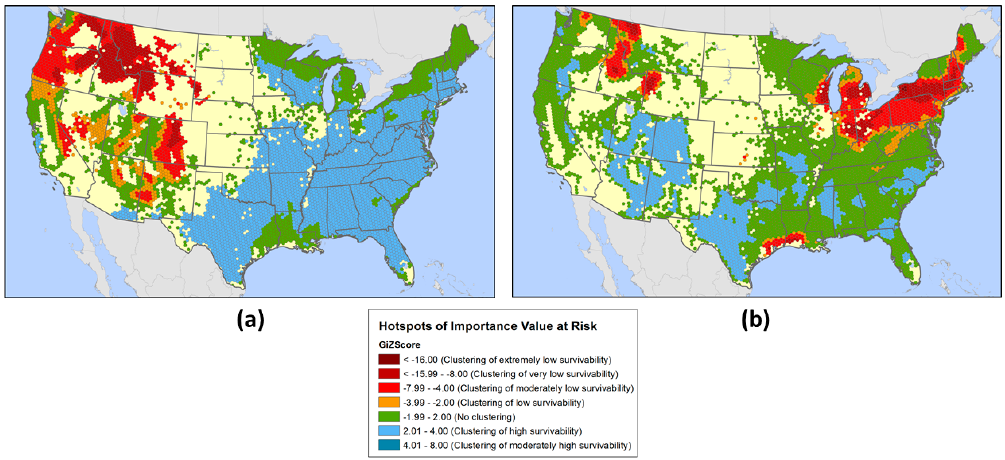
Figure 4. Hotspots and coldspots of Importance Value at Risk (IVAR) for plots within 834 km 2 hexagons, for insect agents. G i * scores ≤ − 2 (red) are significant clusters of low survivability scores (and therefore hotspots of IVAR, the opposite of survivability); scores > 2 (blue) are significant clusters of high survivability values (coldspots of IVAR). ( a ) Hotspots and coldspots of IVAR for native insects. ( b ) Hotspots and coldspots of IVAR for exotic insects.